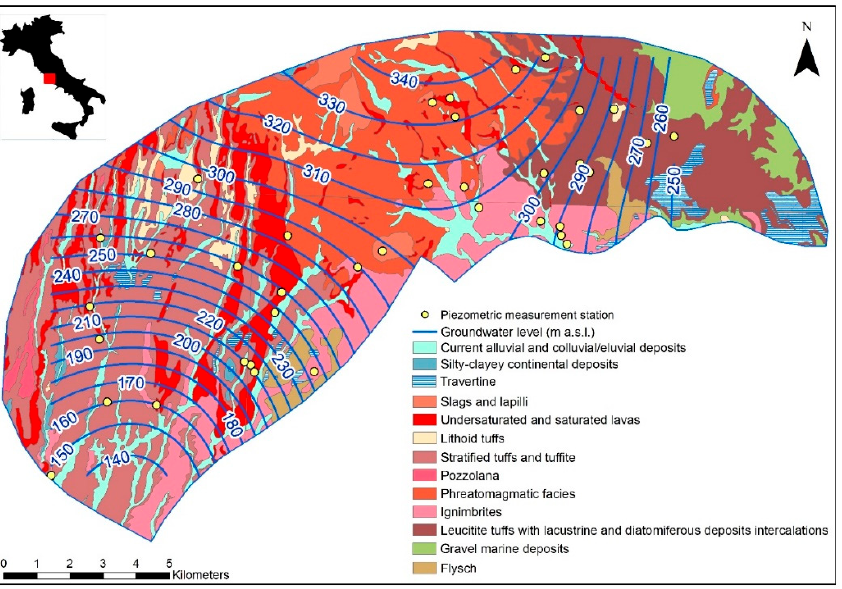
Figure 4. Groundwater level contour map of the southern Mounts Vulsini GWB and outcropping